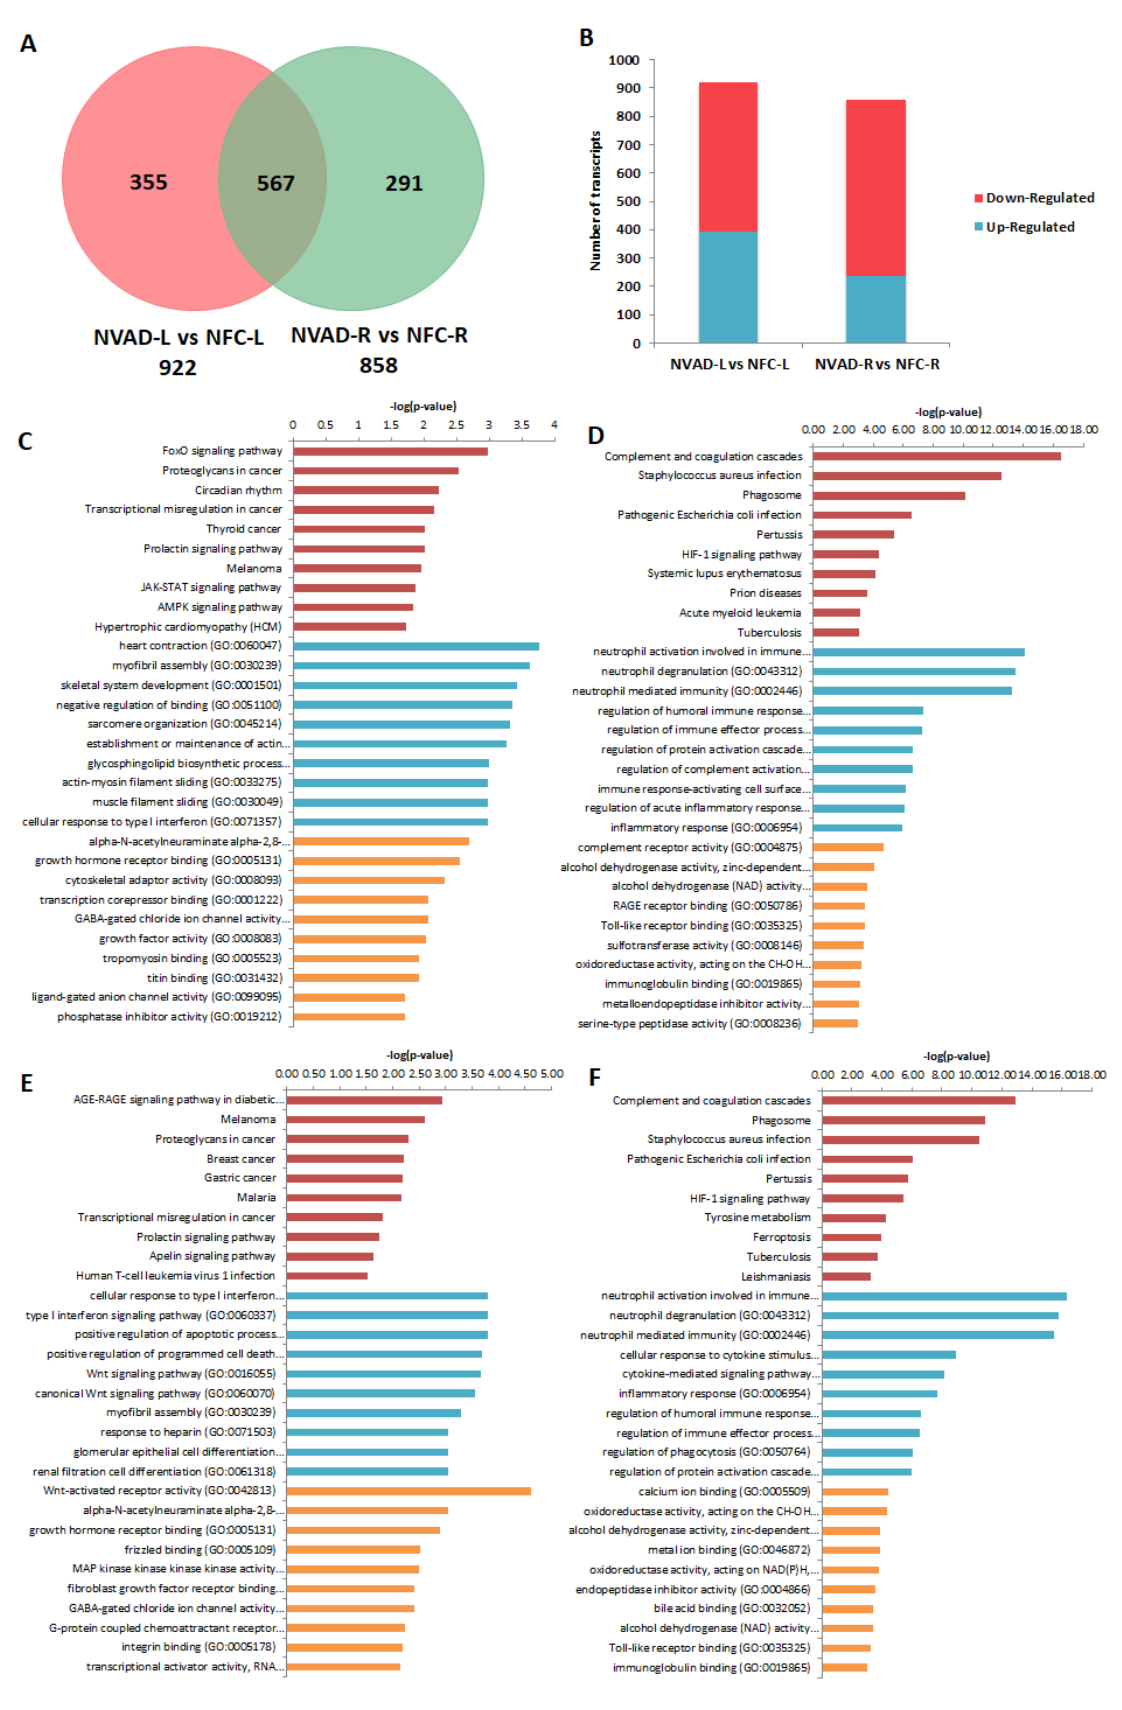
Figure 2. mRNA analysis of dilated cardiomyopathy (DCM) hearts without left ventricle assist device (NVAD) versus non-failing controls (NFC). ( A ) Number of significant differentially expressed transcripts in the left (L) and right (R) ventricles. ( B ) Number of significantly up- and down-regu- lated transcripts in the L and R ventricles. Gene ontology (GO) analysis for ( C , E ) up-regulated and ( D , F ) down-regulated differentially expressed genes in the ( C , D ) L and ( E , F ) R ventricles. The top